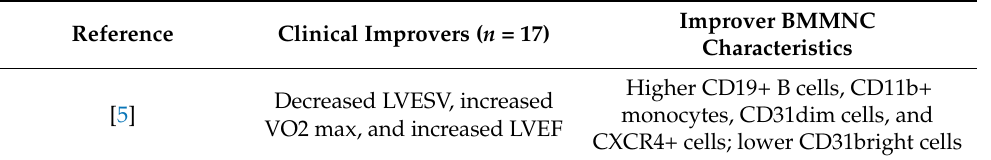
Table 1. FOCUS-CCTRN embedded cohort analysis: Bedside-to-bench outcomes highlight patient subpopulations with distinct BMMNC profiles.